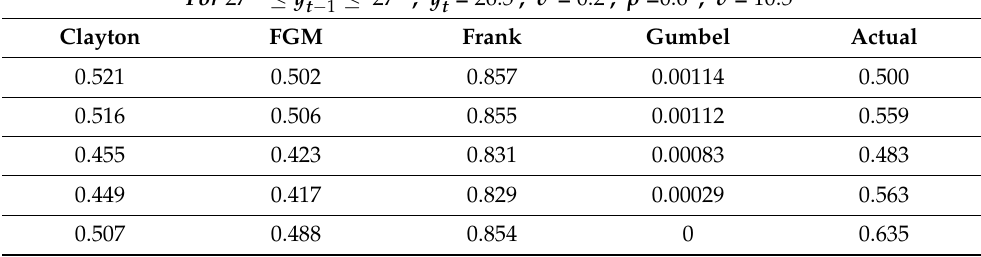
Table 1. Comparing the Copulas based on the conditional probabilities with the actual condi- tional